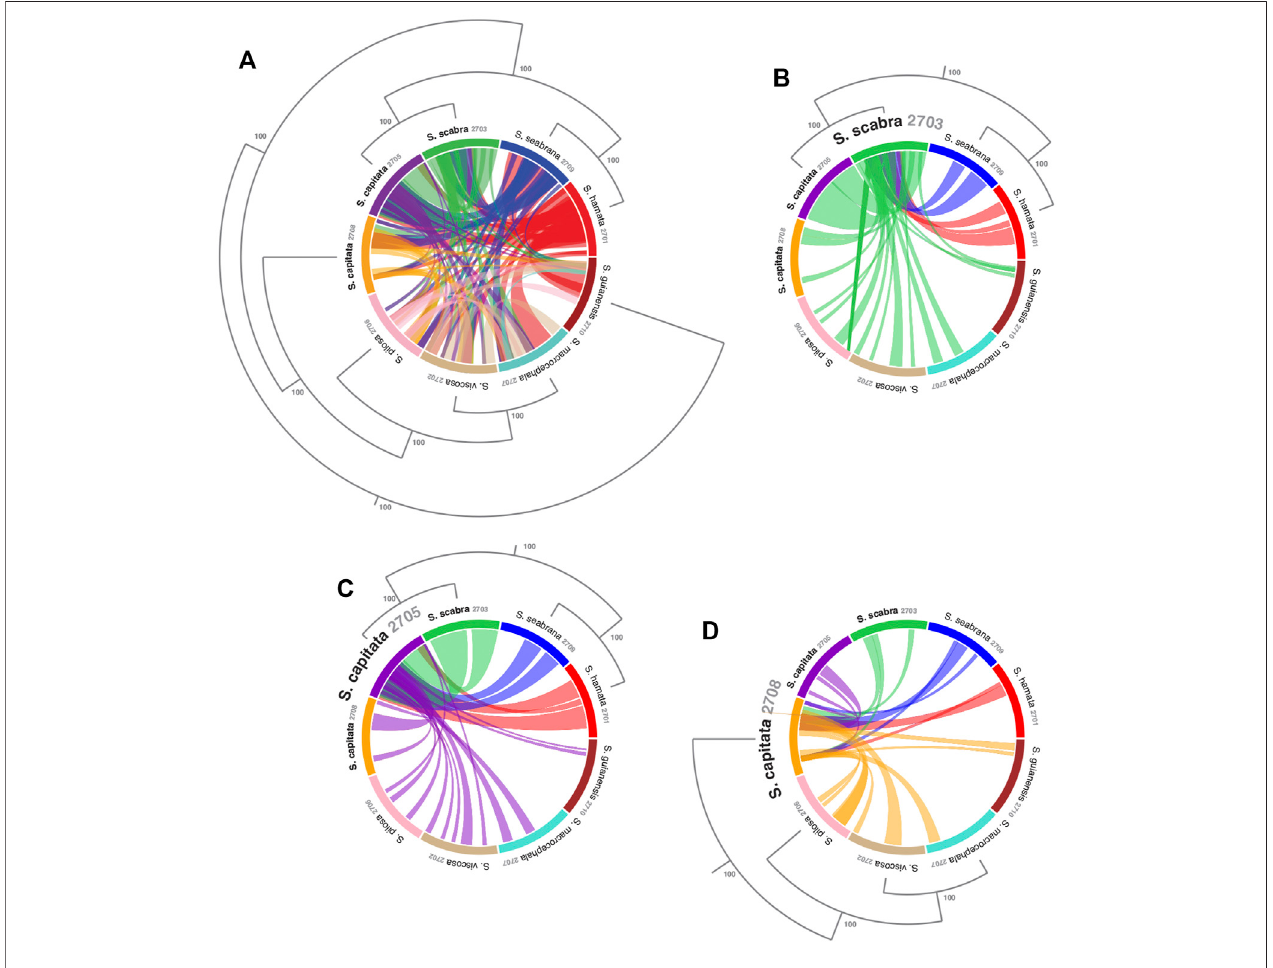
FIGURE 2 | Visualizing sequence similarity among mitogenomes of Stylosanthes species with a focus on the relationships among the allotetraploids. (A) Mitogenomes synteny all-to-all. Synteny of S . scabra mitogenome (B) , S . capitata (SCA 2705) (C) and S . capitata (SCA 2708) (D) to the other species. Phylogenetic relationships were based on the topology of whole plastome alignment analyzed by Bayesian inference. Values in the nodes indicate posterior probabilities.